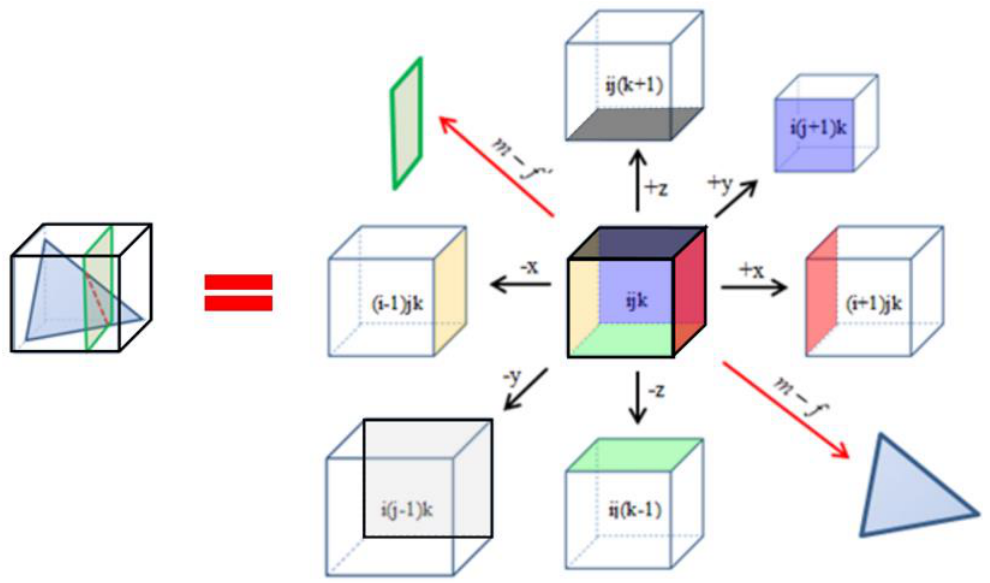
Figure 3. Example of the connections a single grid block with the non-intrusive EDFM, in which two intersecting fractures planes are confined inside a single block, and thereby, eight connections will be calculated. The red arrows show the non-neighboring connections (NNCs) between matrix block “ijk” and the fracture segments [35].